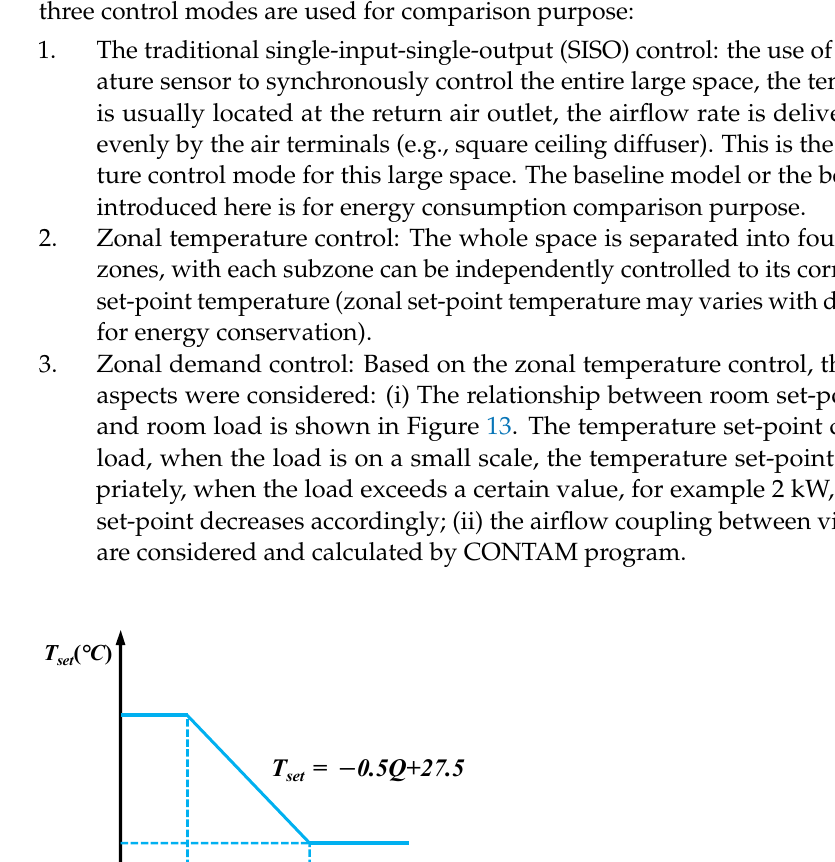
Figure 12. The schematic diagram of airflow coupling.